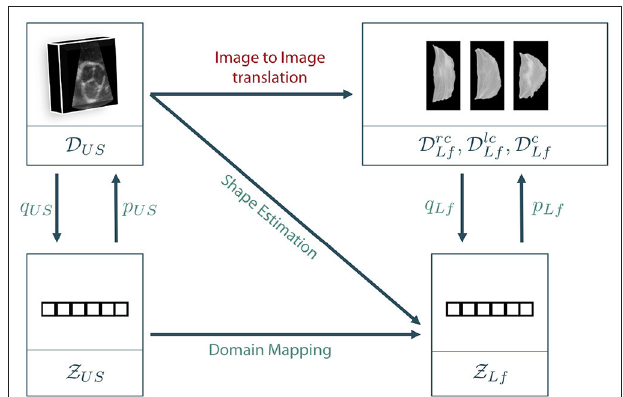
TABLE 3 | Combinations of hyperparameters of the ultrasound autoencoder assessed during hyperparameter analysis. Parameter Values